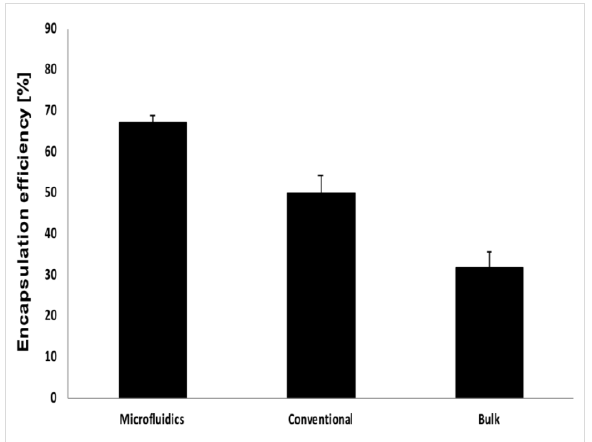
Figure 10: Encapsulation efficiency of curcumin using the different ap- proaches.